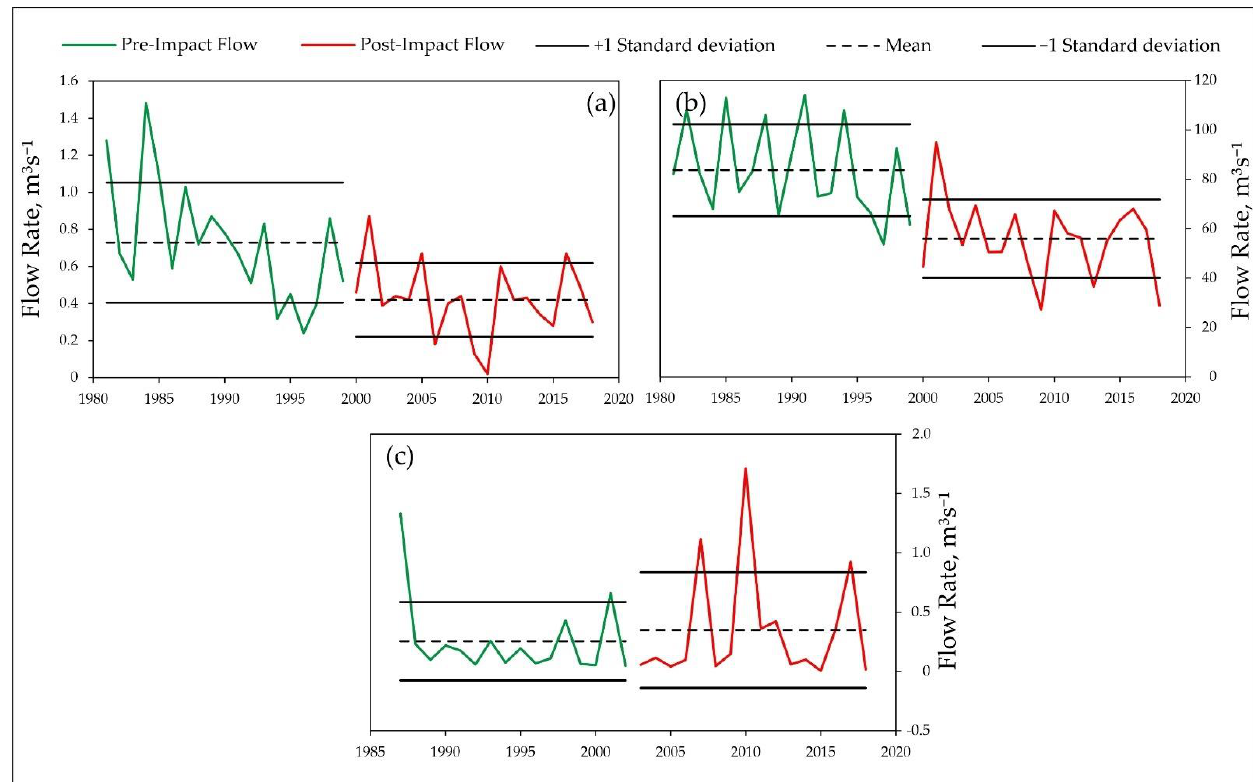
Figure 3. Changes (in m 3 s −1 ) in extreme flow conditions: 1-day minimum flow ( a ) and 1-day maximum flow ( b ) recorded in the Bartuva downstream of Skuodas HPP; 90-day minimum flow ( c ) in the Mituva downstream of Girdžiai HPP.